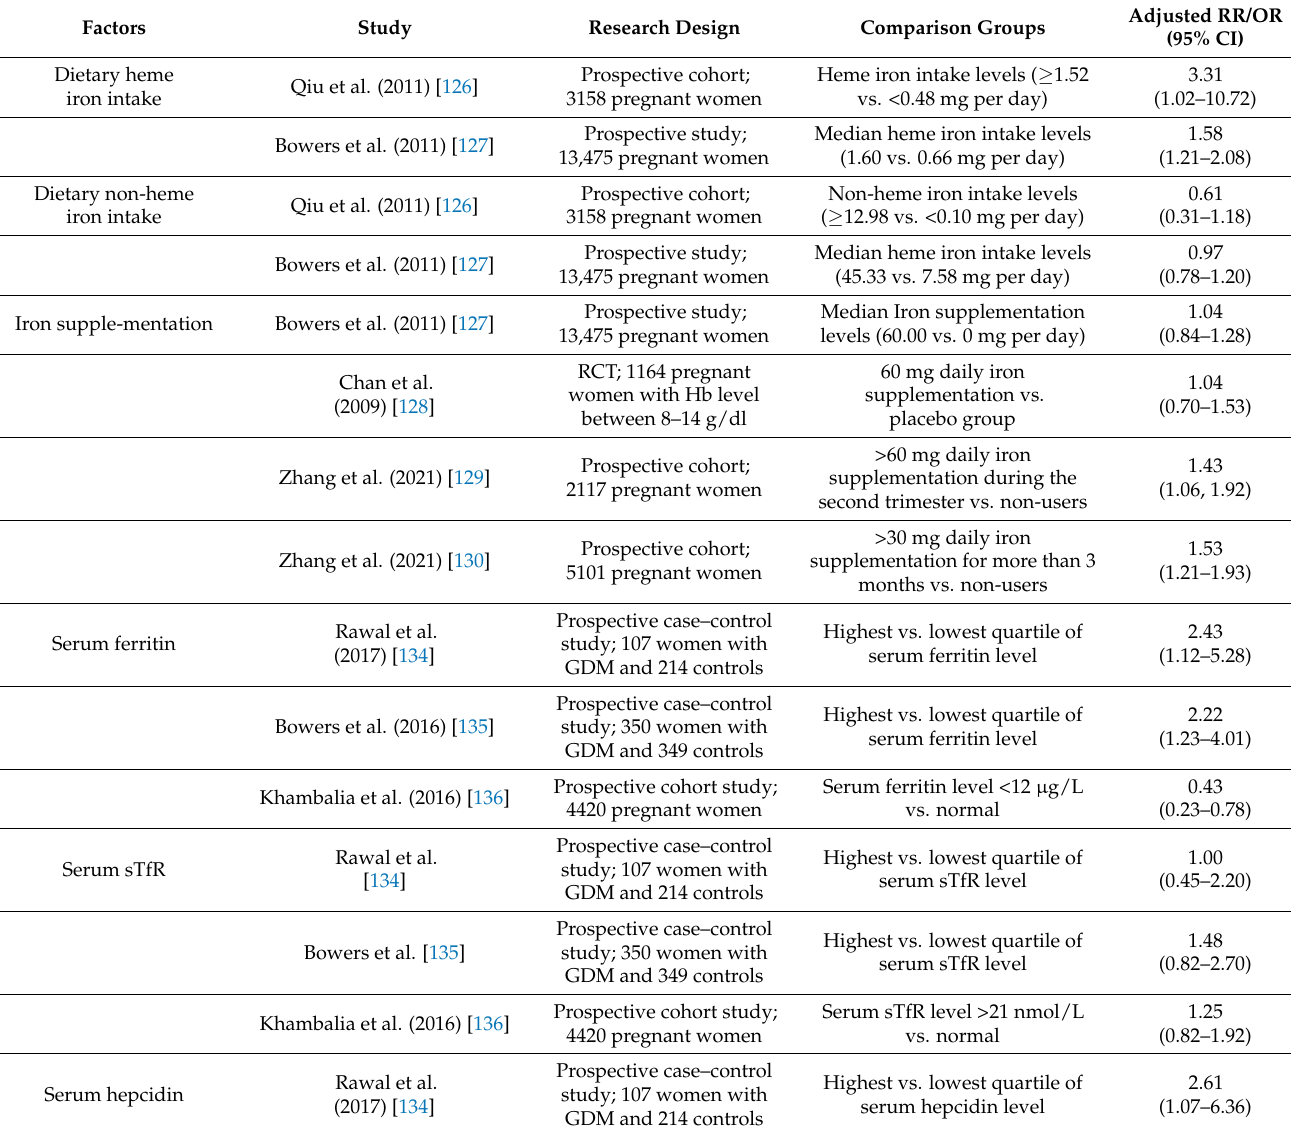
Table 2. Prospective studies reporting iron-related risk factors of